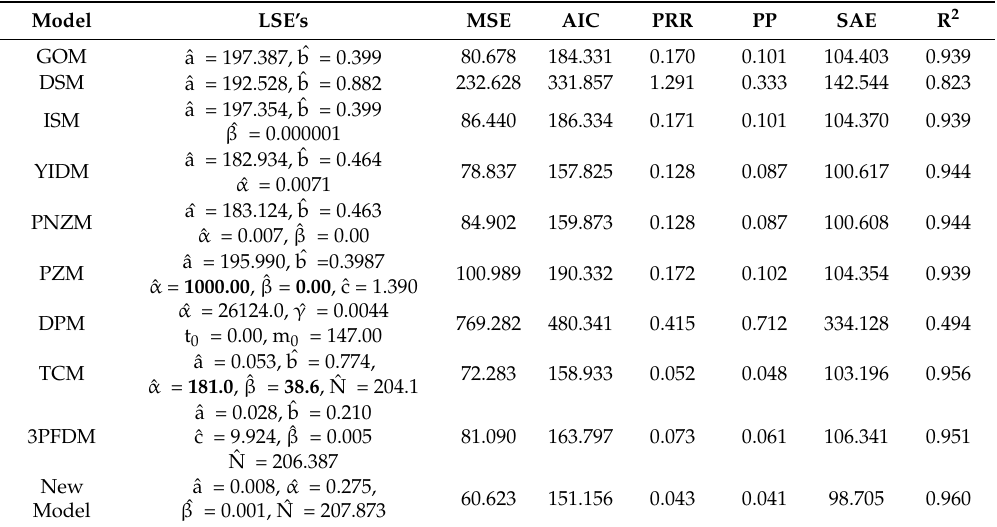
Table 6. Model parameter estimation and comparison criteria from MRS data set (DS2).